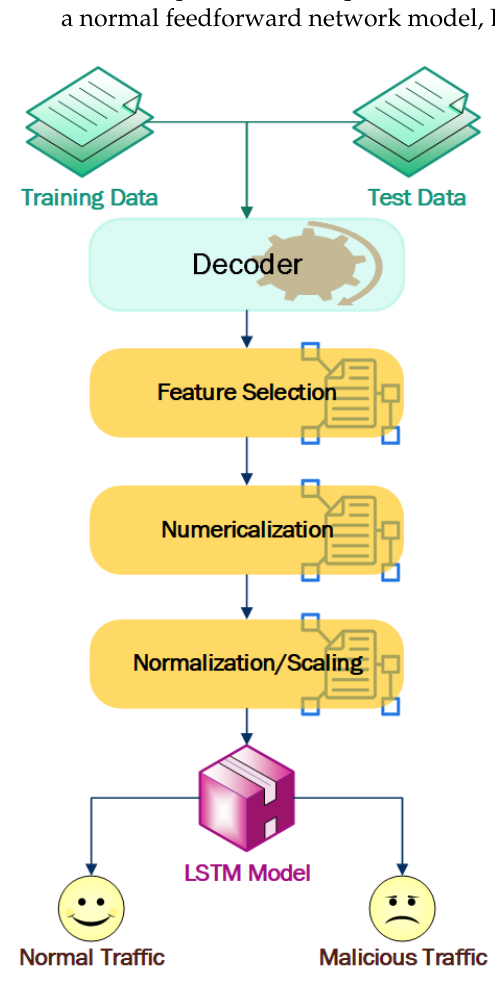
Figure 5. Flowchart of LSTM